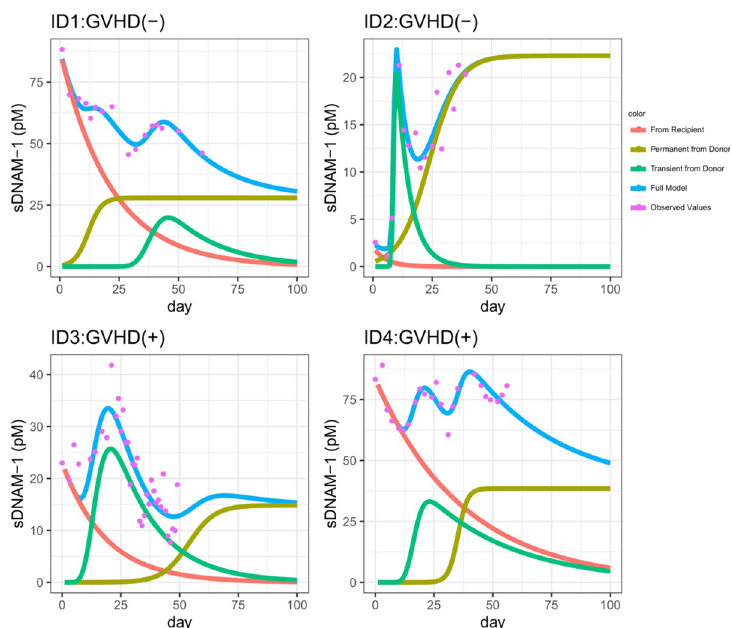
Fig 5. Observed data and simulation of the dynamics of the soluble form of DNAM-1 (sDNAM-1) from different sources. Representative patients Data of sDNAM-1 dynamics after transplantation are shown. The purple dots indicate the observed data. The blue line models the total amount of sDNAM-1; it represents the full model (= x 1 ( t )+ x 2 ( t ) + x 3 ( t )). The green line models the first type of sDNAM-1, namely the transiently type (= x 1 ( t )). The yellow-green line models the second type of sDNAM-1, namely the persistent type (= x 2 ( t )). The red line models the third type of sDNAM-1, namely the residual type produced by recipient (= x 3 ( t )). Thus, the blue line (total concentration of sDNAM-1) consists of the green, yellow-green, and red lines combined. Patients ID1 and ID2 did not develop aGVHD, whereas patients ID3 and ID4 did develop it.